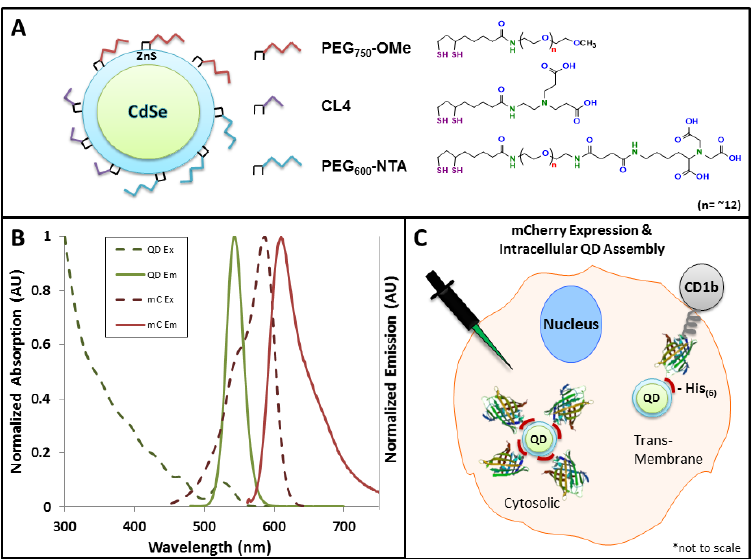
Figure 1. Fluorescent materials and Förster resonance energy transfer (FRET) rationale used in this study. ( A ) Schematic of CdSe-ZnS core-shell quantum dots (QDs) and various capping ligands; ( B ) Absorption and emission spectra of the QD and mCherry (mC) donor–acceptor pair showing significant overlap of the QD emission and mCherry absorption, allowing for FRET-sensitized